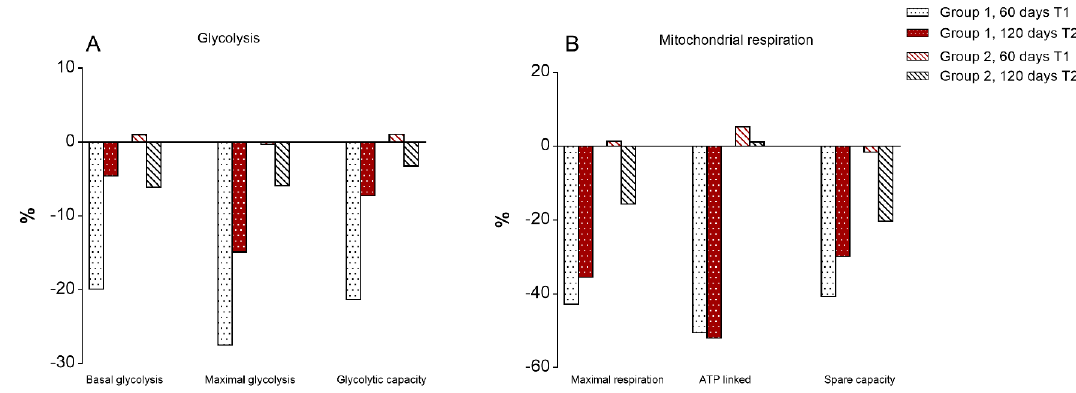
Figure 6. Percentage changes in metabolic parameters ( A ) Glycolysis; ( B ) Mitochondrial respiration) of PBMCs isolated from children at 60 and 120 days compared to baseline upon 12 h OKT3 stimulation. White = RCR, Red = RCR + Tomato. Statistically significant differences are reported in Figure S3.